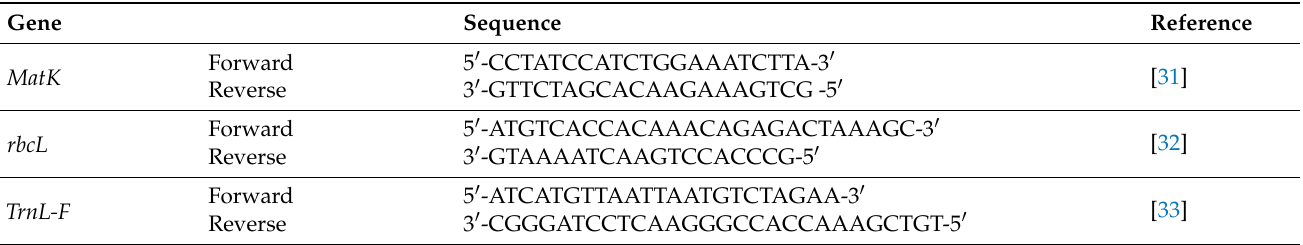
Table 1. Primers used for